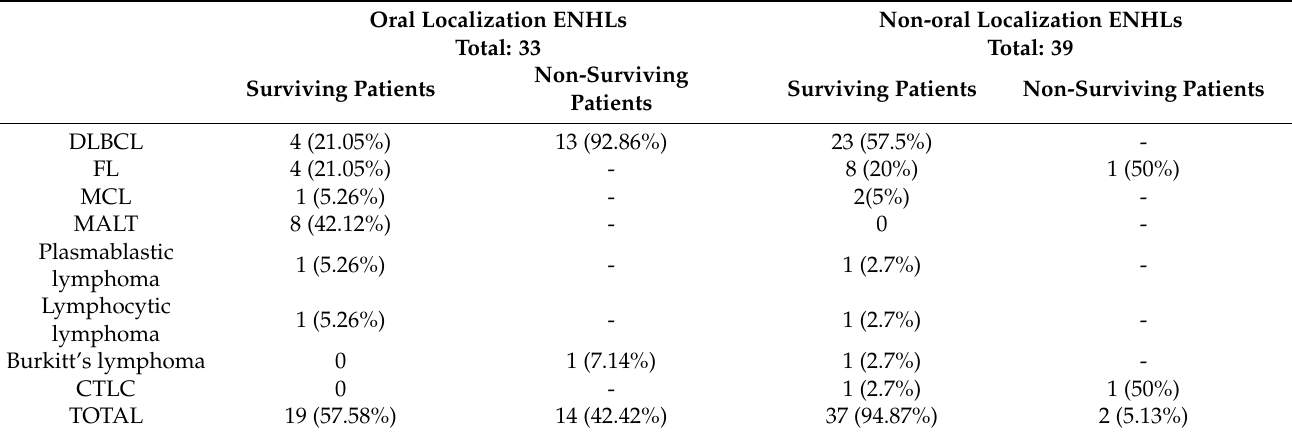
Table 4. Five-year follow-up survival of oral and non-oral